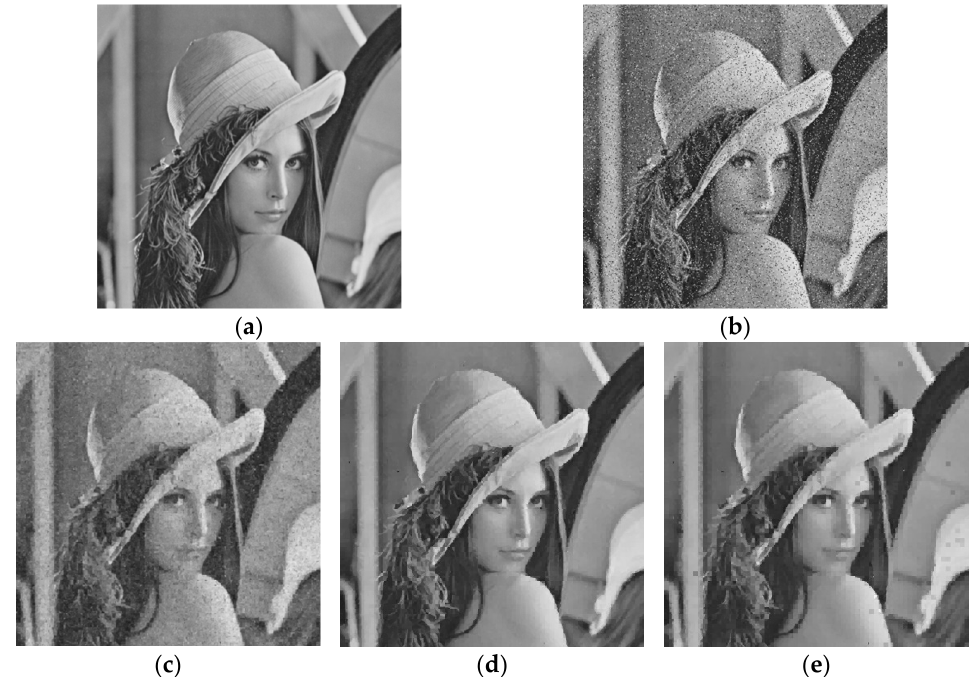
Figure 1. Retrieved images by Full search FIC-LS, RMFIC-H, and RMFIC-TB for Lena image corrupted by 10% salt and pepper noise. ( a ) Original image, ( b ) Corrupt image, ( c ) FIC-LS 23.31 db/9.70 s, ( d ) RMFIC-H 28.10 db/973.45 s, ( e ) RMFIC-TB 26.46 db/5670.20 s.